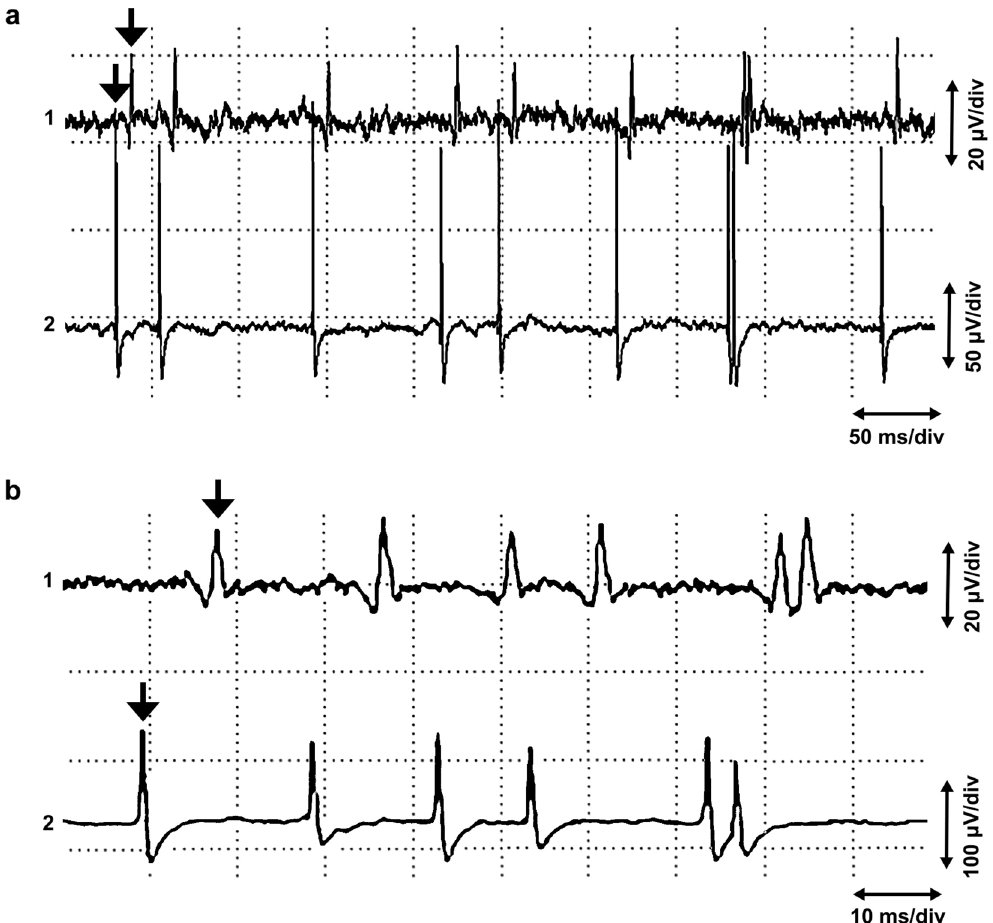
Figure 4. Exactly correlated end plate spikes in two active sites in different fasciculi in channels 1 and 2 ( a,b ) arrows, different time and amplitude calibration). The extensor carpi radialis muscle. The electrodes are